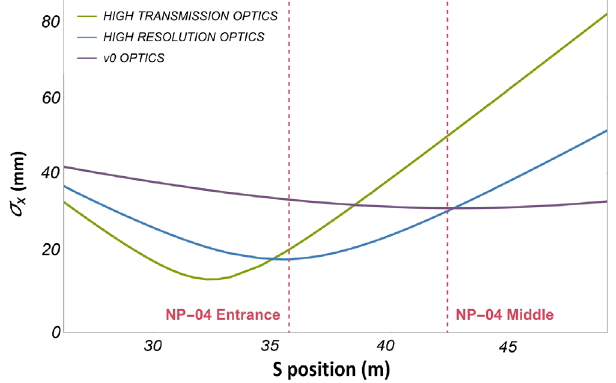
FIG. 3. Bending plane beam size in H4-VLE near the detector entrance for a 7 GeV =c beam, as simulated via PTC . It is shown that in the bending plane, the high-transmission optics results in a much smaller spot-size at the NP-04 entrance, at the expense of a bigger spot-size at the middle of the cryostat. The high resolution optics gives even smaller spot size at the entrance and the center of the cryostat, at the expense of the rate, as discussed in the text.